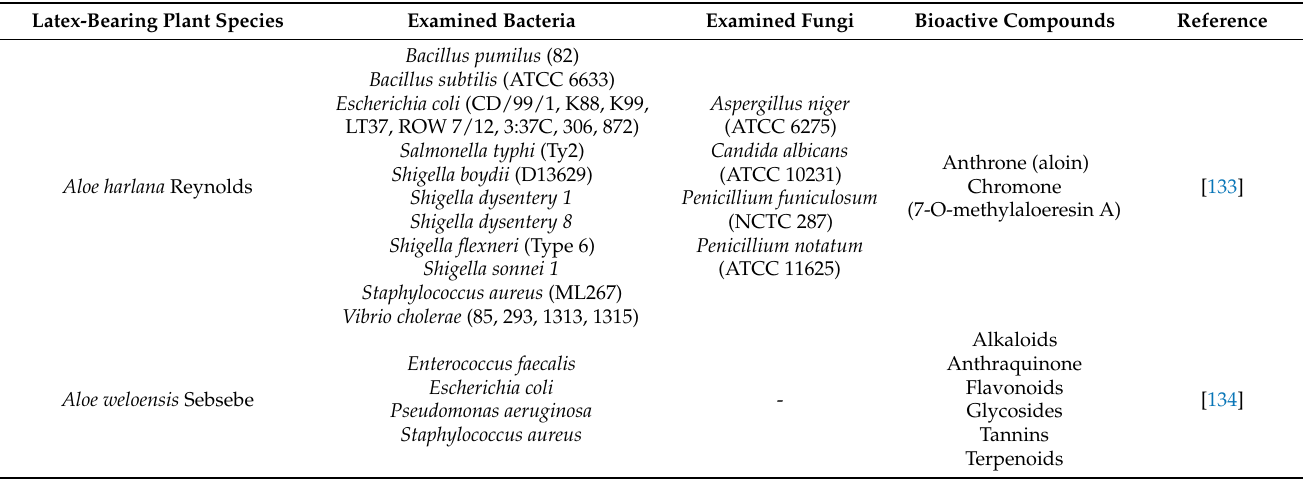
Table 3. Examples of antimicrobial activity of latex bearing